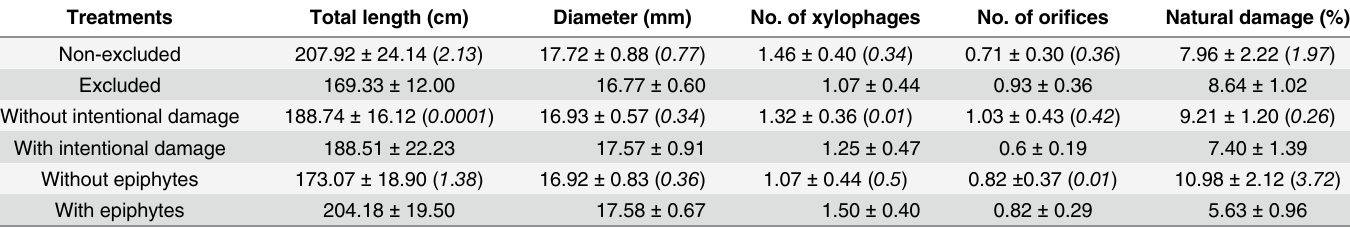
Table 1. Mean ( ± SE) of the variables measured in branches of the tree Ipomoea murucoides subjected to three main treatments (factors): exclu- sion (excluded vs . non-excluded branches), intentional damage (branches with intentional damage vs . branches without intentional damage) and with the presence/absence of T . recurvata (N = 28). No single variable showed statistical differences between factor levels (P > 0.05). F 1,48 values of the variables within each factor were in italics and in parenthesis.